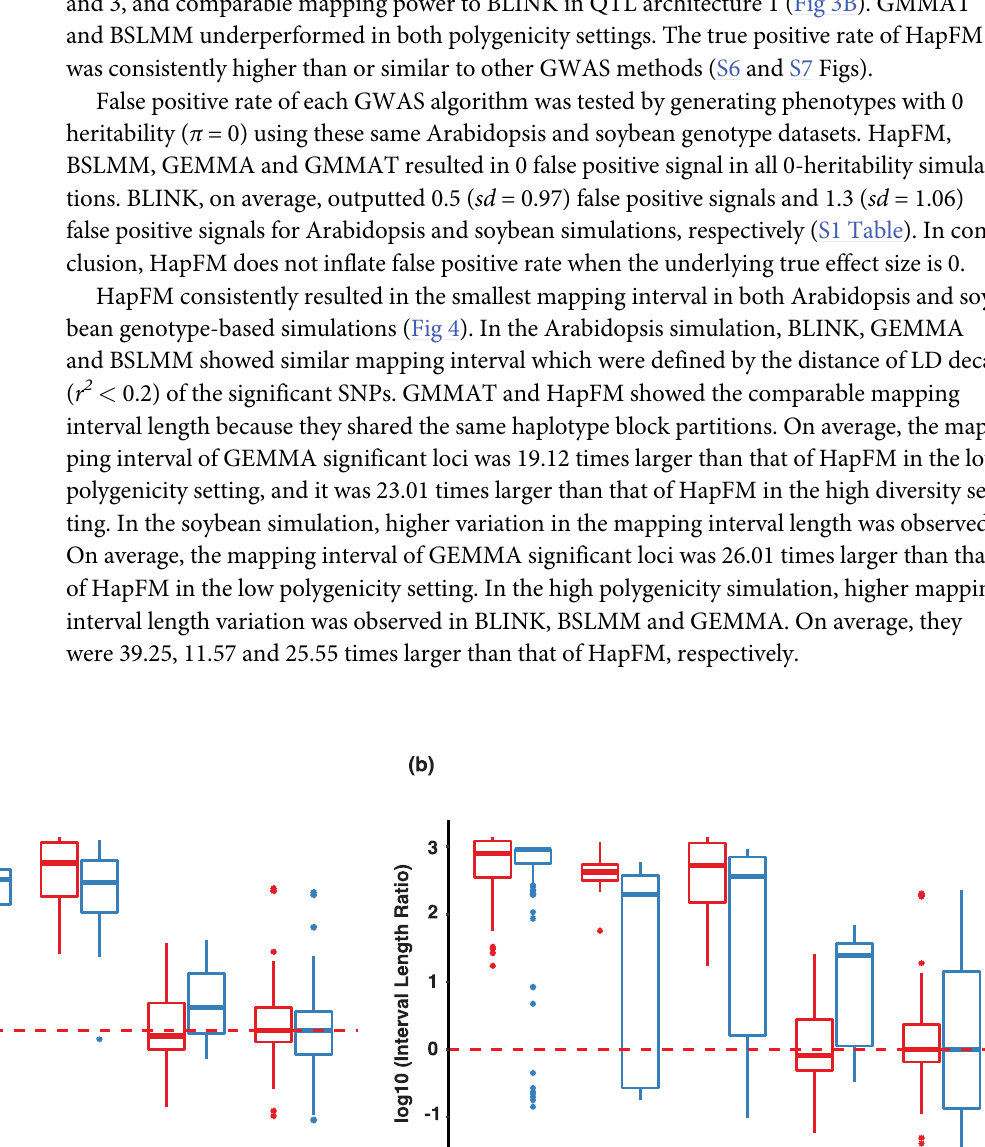
PLOS Genetics | https://doi.org/10.1371/journal.pgen.1010437 October 17,